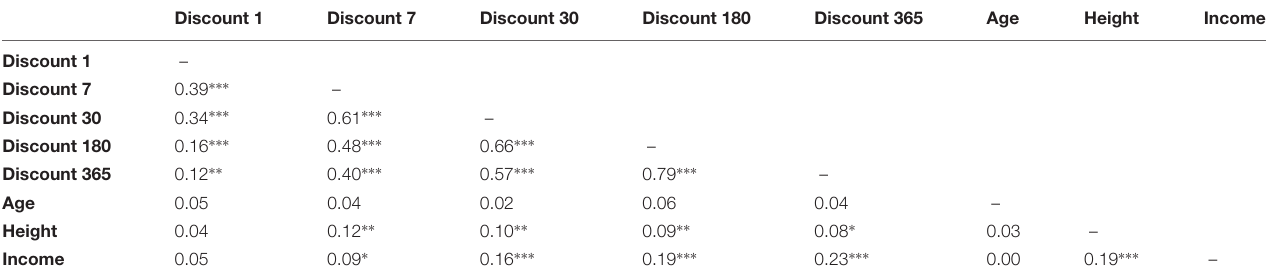
TABLE 1 | Pearson’s bivariate correlations among continuous variables.